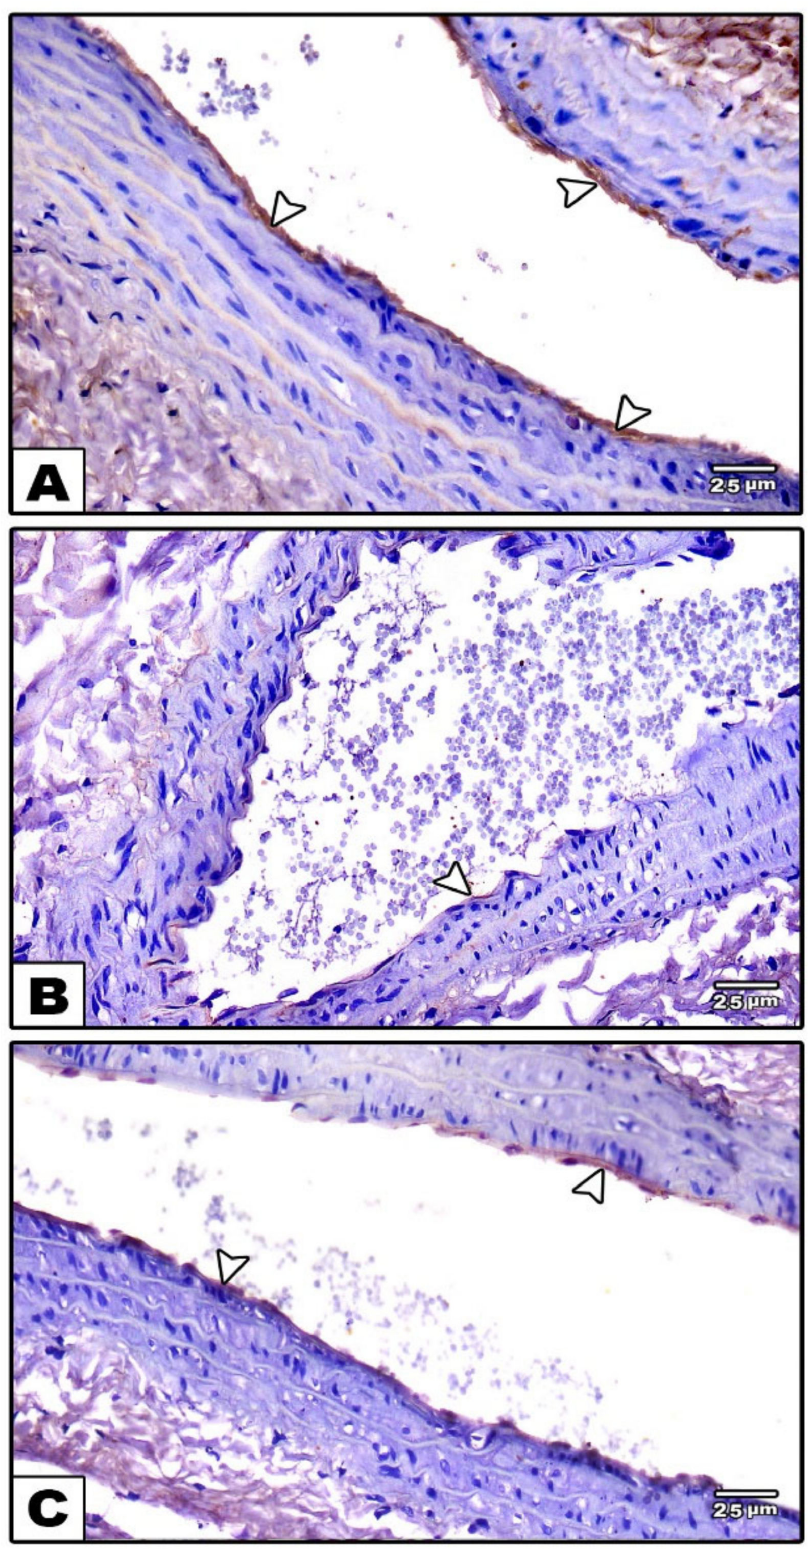
Figure 3. Photomicrographs of sections in the carotid artery immunohistochemically stained with eNOS. ( A ): In the control groups, strong positive eNOS immunoreactivity is observed in the endothe- lial lining of the tunica intima (arrowheads). ( B ): In the reserpine-treated group, decreased eNOS immunoreactivity (arrowheads) is observed ( C ): In the fisetin-treated group, weak positive eNOS immunoreactivity (arrowheads) in the endothelial lining of the tunica intima is